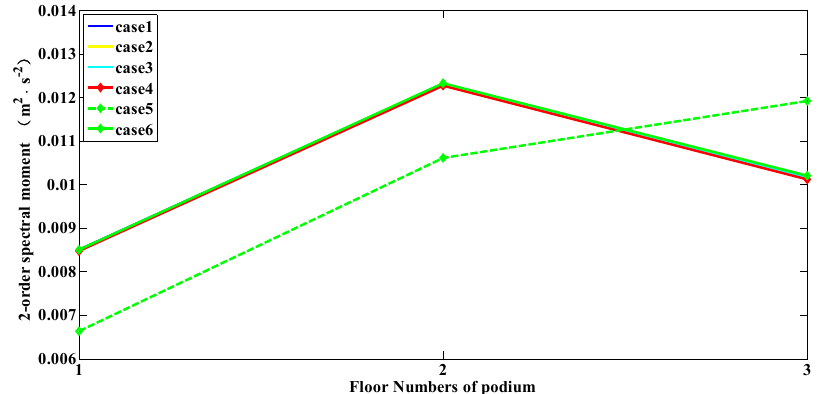
Figure 10. Second-order spectral moment of displacement of each layer of the podium .